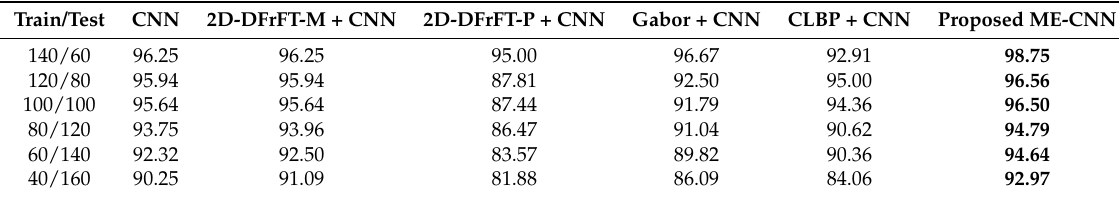
Table 11. Classification accuracies with different numbers of training samples (%) for the BCCT200-resize data. Train/Test